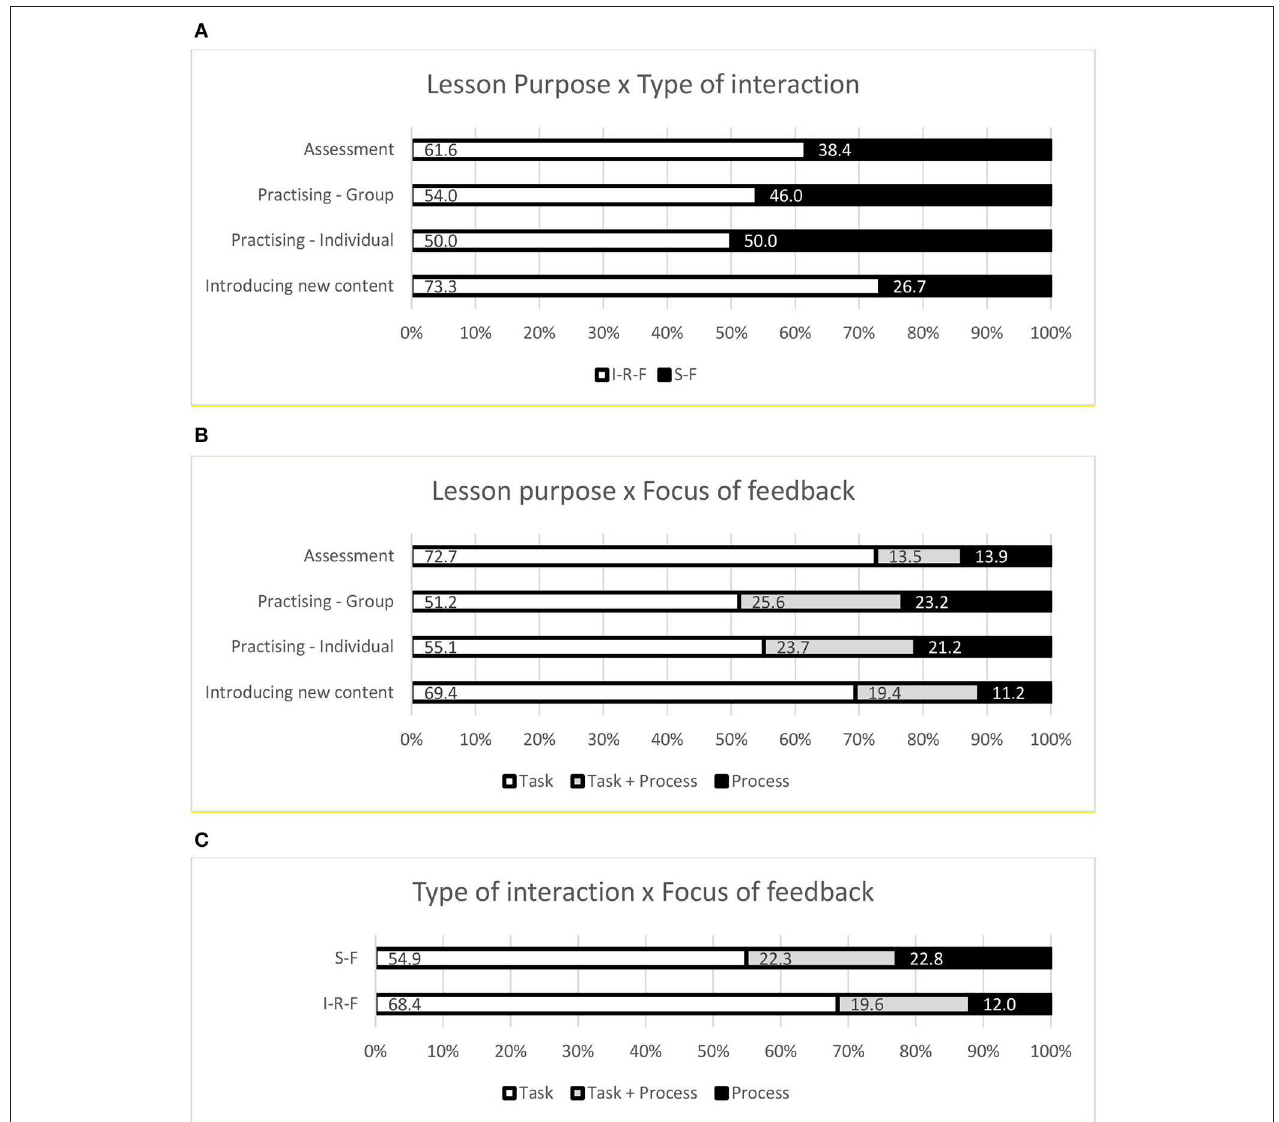
FIGURE 1 | Graphical representation of the association between the Lesson purpose and the Type of interaction (A) , between the Lesson purpose and the Focus of feedback (B) , and between the Type of interaction and the Focus of feedback (C)